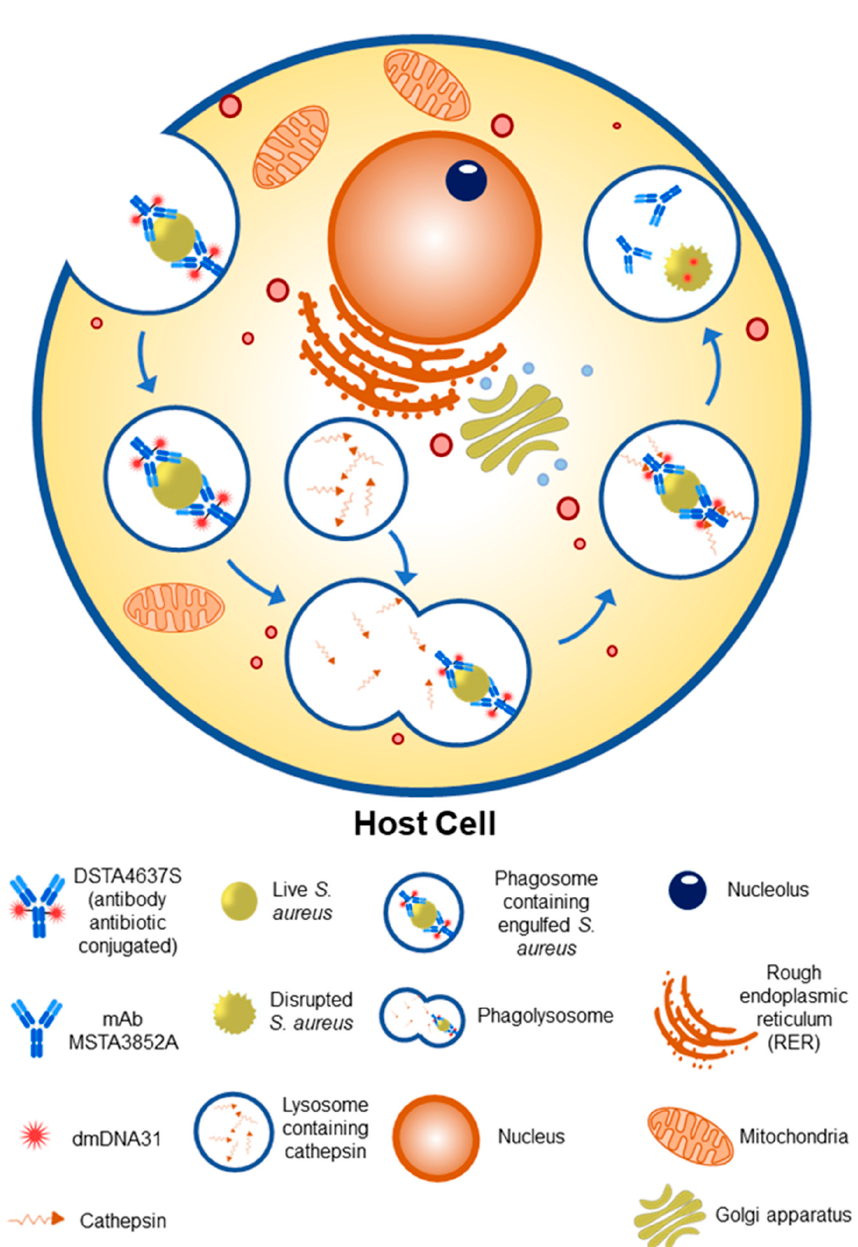
Figure 4. Mechanism of killing intracellular S. aureus by DSTA4637S. DSTA4637S binds to S. aureus, enhancing phagocytosis. Following internalization by host cells, it fuses with the phagolysosome where lysosomal cathepsins cleave the vc linker releasing the antibiotic dmDNA31. dmDNA31 is responsible for killing the intracellular pathogen. Table 1. Monoclonal-antibody-based biologics that are FDA approved or in clinical trials for the treatment of sepsis.